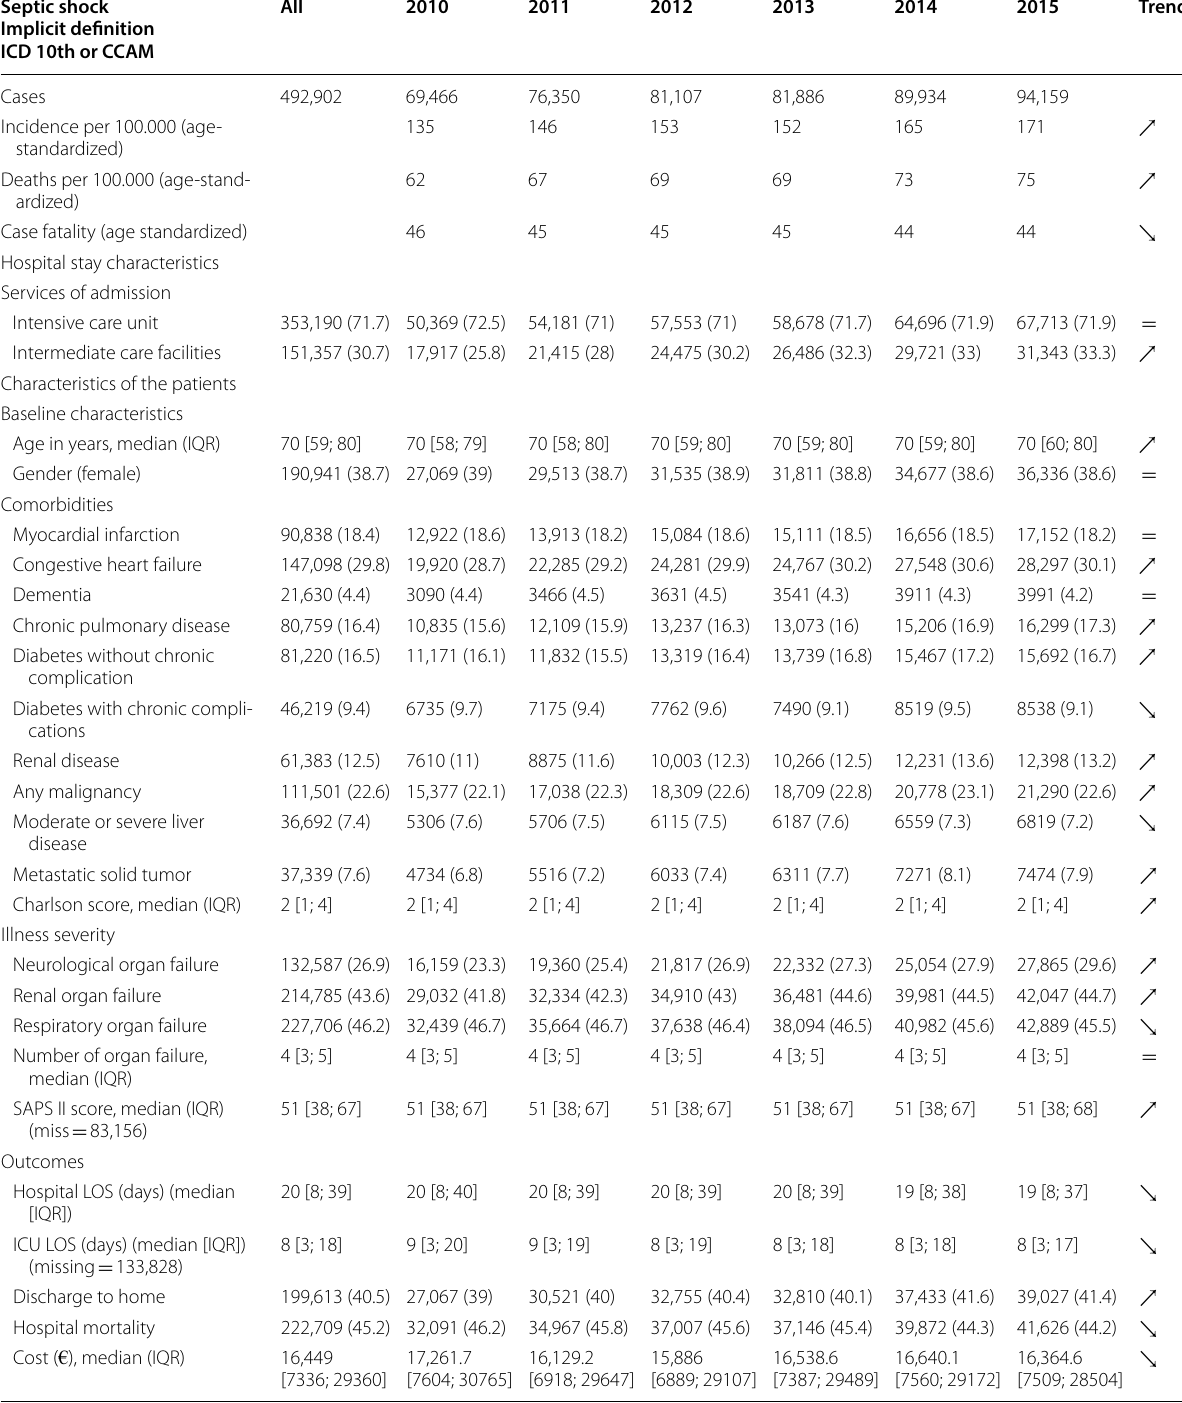
Table 2 Main characteristics of the included septic shock hospital stays in France between 2010 and 2015 and their associated temporal